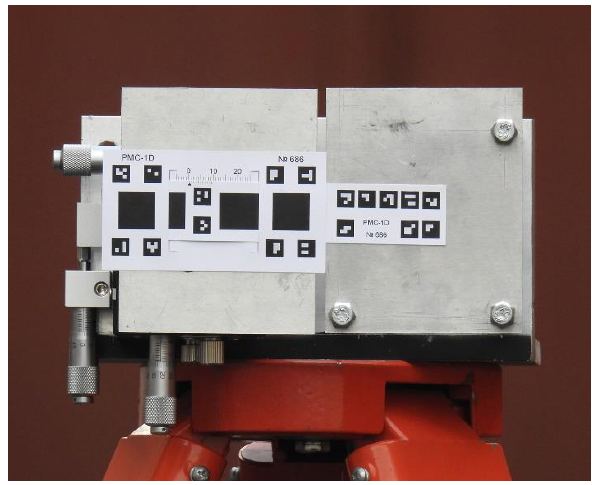
Figure 12. A marker fixed on a mechanical micrometer. The marker was photographed with a Nikon Coolpix P900 camera sequentially from distances of 1, 10, 20, 30, 40 and 50 meters with equivalent focal lengths from 100 mm to 2000 mm.